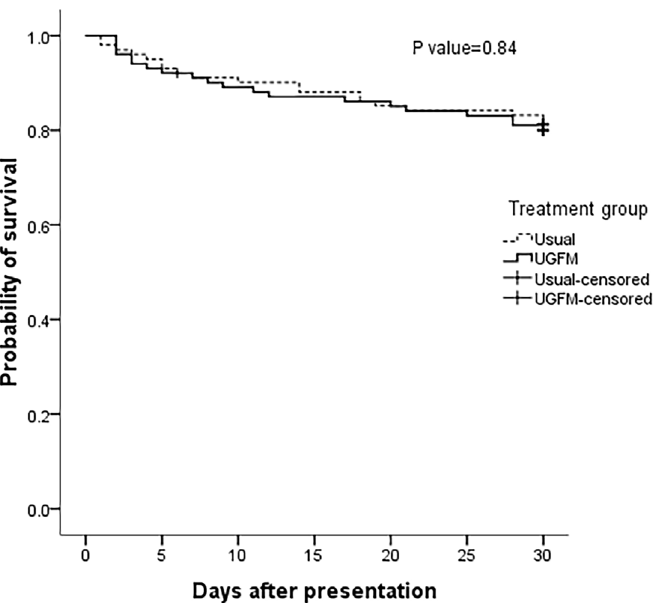
Figure 2. Kaplan–Meier curves showing the probability of survival among patients treated with ultrasound-guided fluid management or the usual-care strategy (intention-to-treat analysis). The hazard ratio was 0.94 (95% confidence interval [CI], 0.50 to 1.75), P>0.05 by log rank